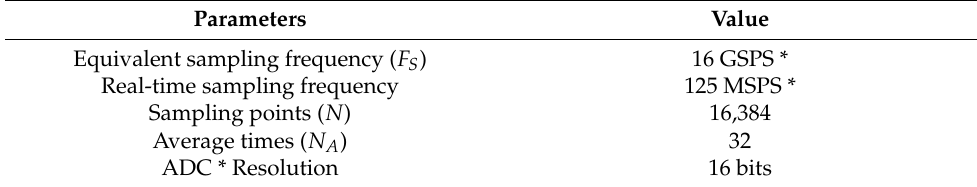
Table 2. Key parameters of the proposed